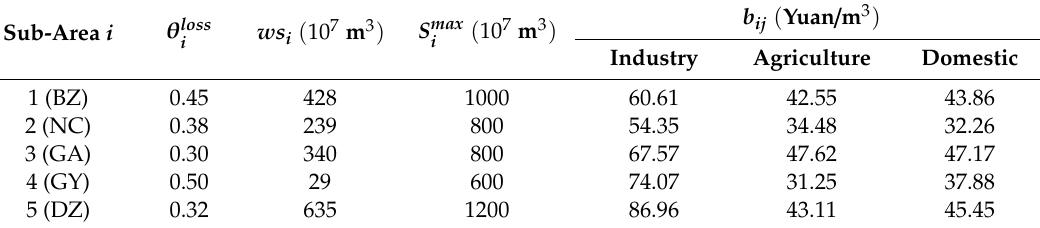
Table 2. Model Parameters—storage capacity, loss rate, and economic benefit of sub-areas.